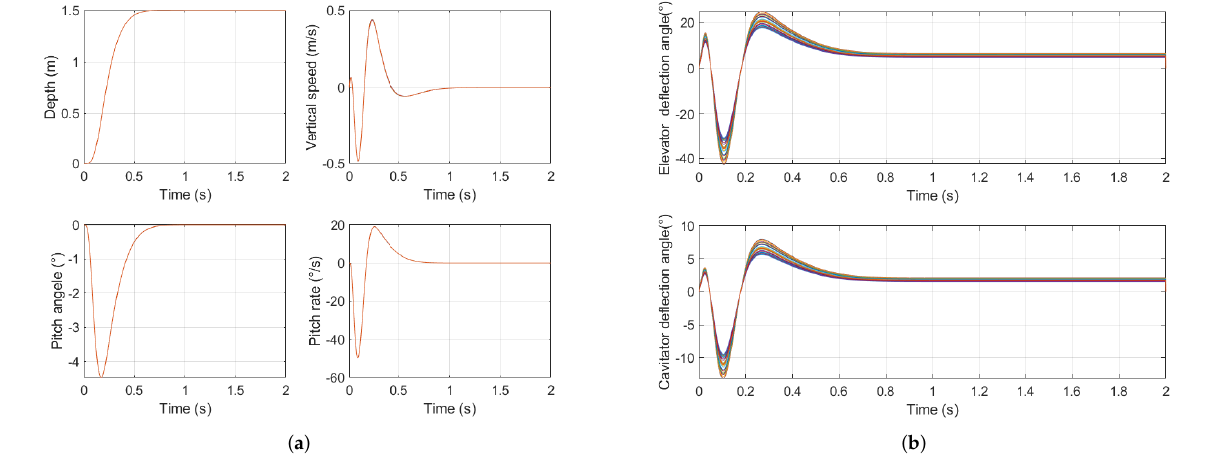
Figure 13. Monte Carlo simulation with perturbation of R n : ( a ) Four states with perturbation of R n ; ( b ) Actuator with perturbation of R n